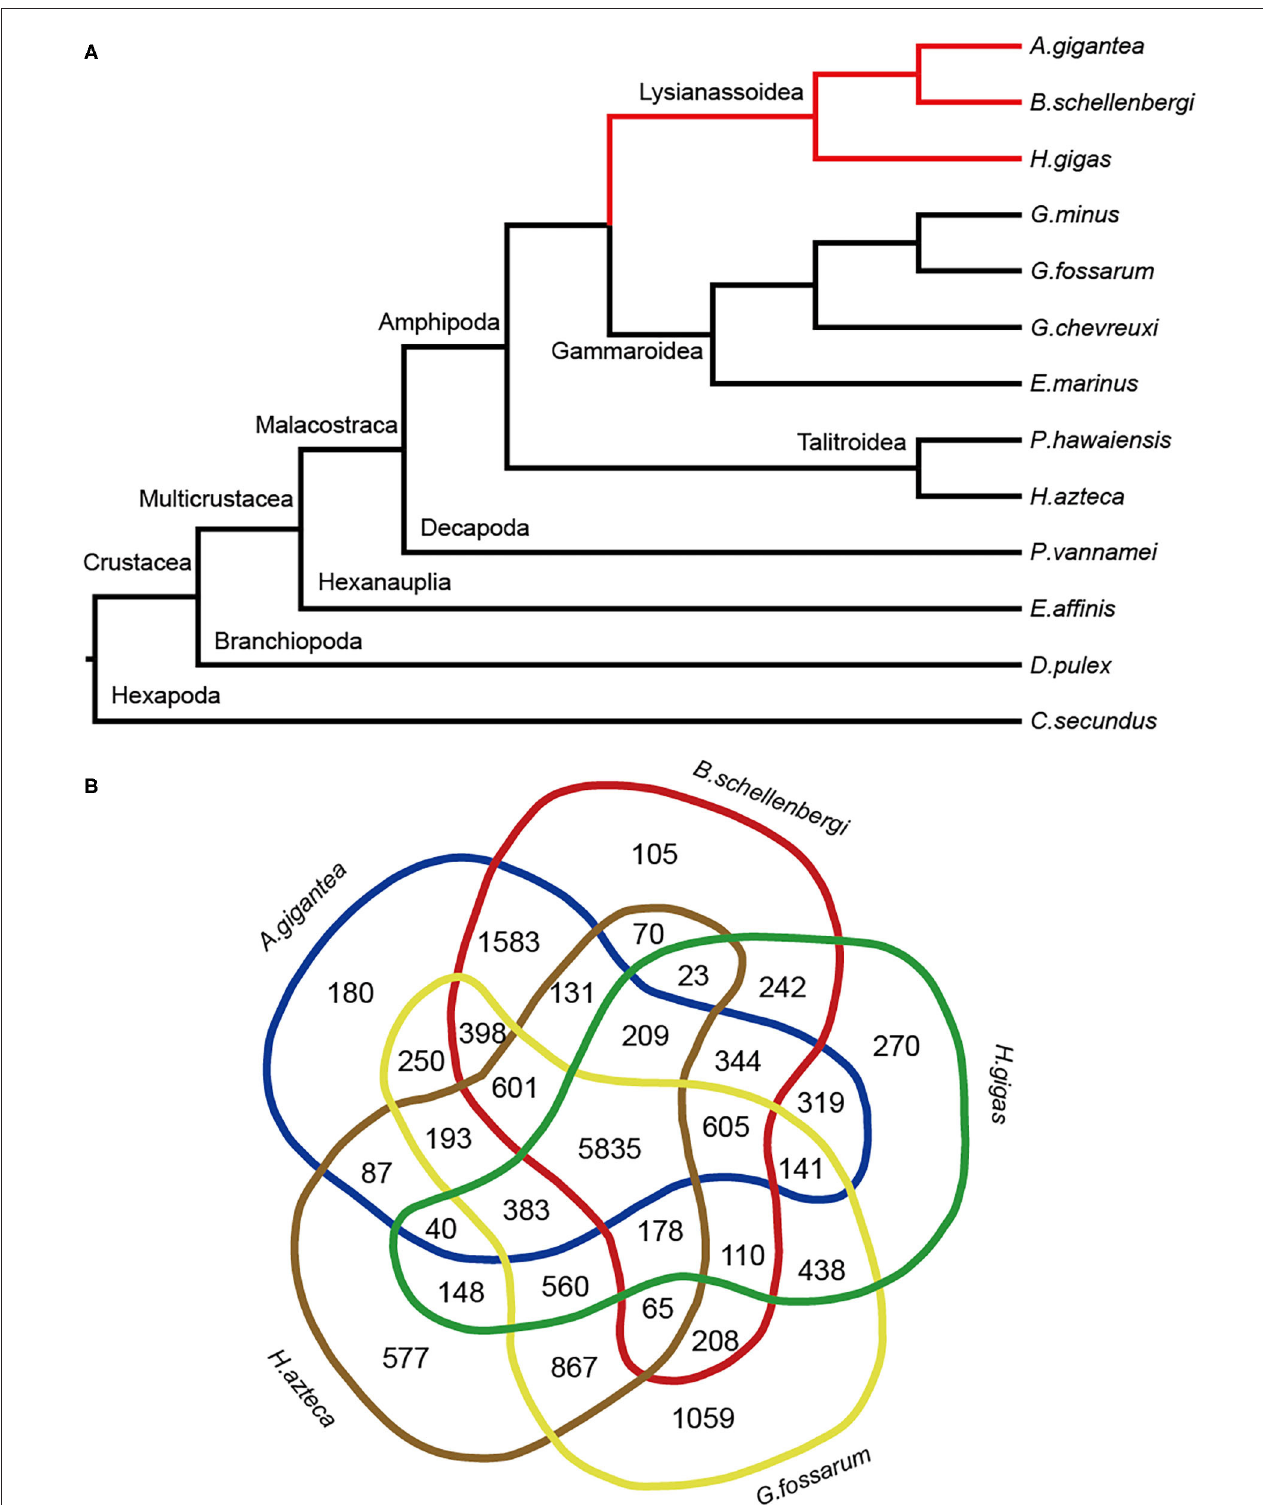
FIGURE 3 | Evolution and homology analysis. (A) Phylogenetic analysis of A. gigantea , B. schellenbergi, and other arthropods. The hadal species were clustered in the clade Lysianassoidea. A. gigantea showed a close phylogenetic relationship with B. schellenbergi . All nodes received 100% bootstrap support. (B) Comparisons of the predictive genes between A. gigantea , B. schellenbergi , Hirondellea gigas , Hyalella Azteca , and Gammarus fossarum . A. gigantea and B. schellenbergi have more gene families in common.